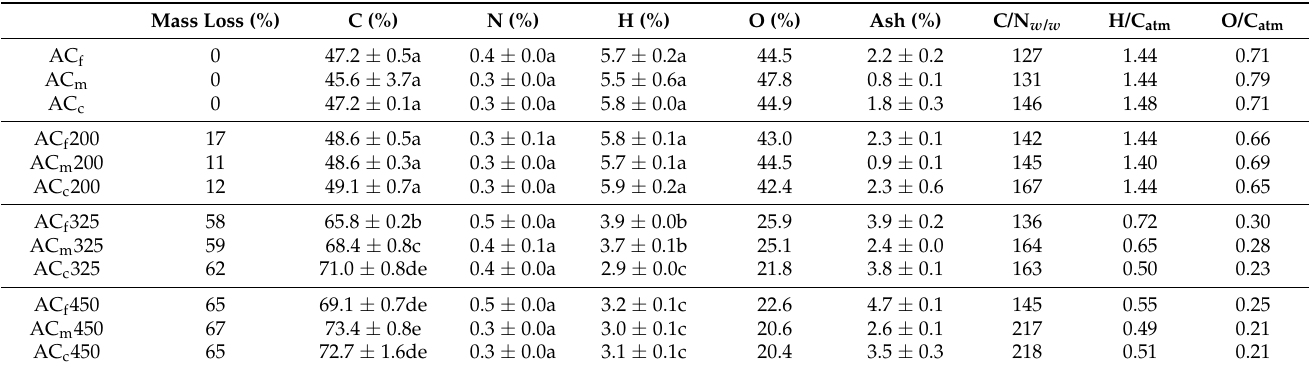
Table 2. Mass loss (%) and elemental composition of Acrocomia nutshells and its biochars as a function of pyrolysis temperature and particle size of the feedstock and of the produced biochars. Values in the columns are means ± standard deviation (n = 3). For Tukey’s post hoc tests, the samples were grouped into two groups. The first group comprised the uncharred and biochars produced at 200 ◦ C, whereas the second was composed of the biochars pyrolyzed at 325 ◦ C and 450 ◦ C. Numbers followed by the same letter indicate no significant differences at the p < 0.05 level. The O contents were calculated by difference. The elemental composition was used to calculate the C/N ( w / w ) (C/N w / w ), atomic H/C and O/C values (H/C atm ; O/C atm